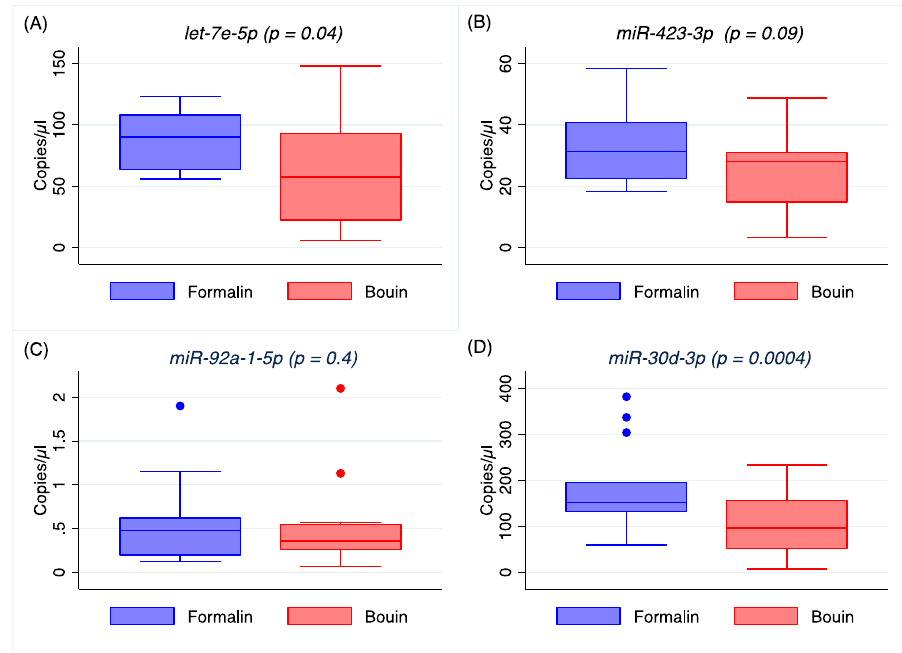
Figure 3. Box plot representing the quantitative reverse transcription polymerase chain reaction (RT / ddPCR) of let-7e-5p ( A ), miR-423-3p ( B ), miR-92a-1-5p ( C ), and miR-30d-5p ( D ) in matched formalin- and Bouin’s-fixed tissues by ddPCR. The box represents the first and third quartiles, intersected by the median, and the whiskers are the